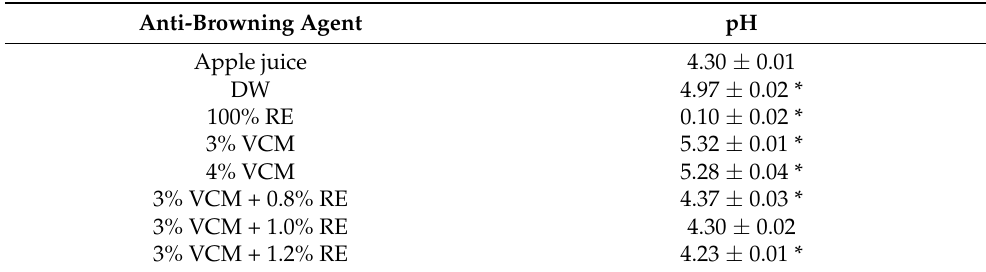
Figure 1. Evaluation of browning index over storage period. Freshly cut apples were treated with anti-browning agent for 1 min, followed by measurement of the ∆ BI values for 12 days. Statistical significance was determined by one-way ANOVA (mean ± SE, n = 4). Table 1. Measurement of pH values of the anti-browning agent solution.